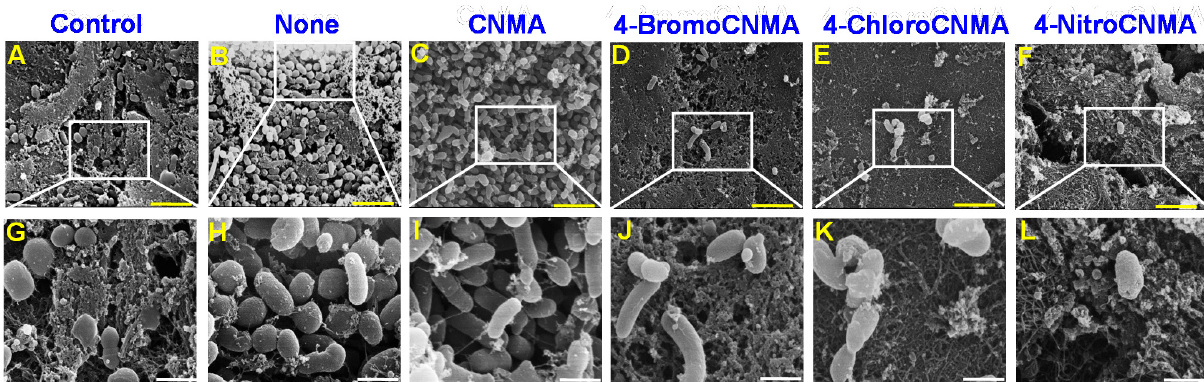
Figure 5. SEM images of squid surface infected with V. parahaemolyticus and treated with or without CNMA and its analogs. The control represents squid surface without V. parahaemolyticus ( A , G ) while none is squid surface + V. parahaemolyticus without treatment ( B , H ) and the treated groups; CNMA ( C , I ), 4-BromoCNMA ( D , J ), 4-ChloroCNMA ( E , K ), 4-NitroCNMA ( F , L ). Yellow and white scale bars are 6 µm and 1.5 µm, respectively.